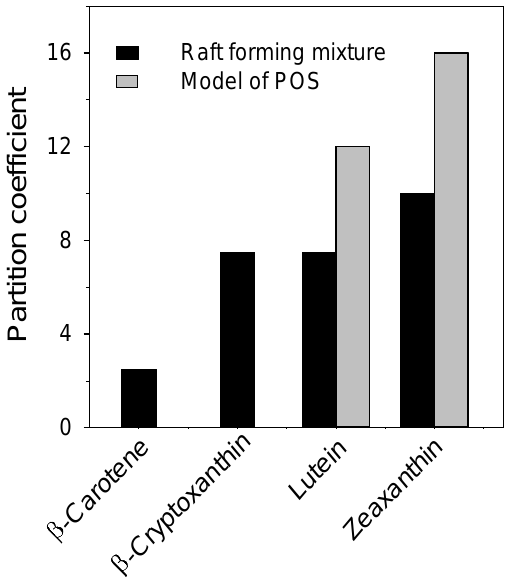
Figure 5. Partition coefficient of dipolar xanthophylls (lutein and zeaxanthin), monopolar xanthophyll (β-cryptoxanthin) and nonpolar carotenoid (β-carotene) between the bulk (unsaturated) domain and the raft (saturated) domain in the membrane made of the raft-forming mixture and in the model of photoreceptor outer segment (POS) membranes. The unsaturated domain in the model of POS membranes is abundant in DHA, with six double bonds. For more details, see [100,101].